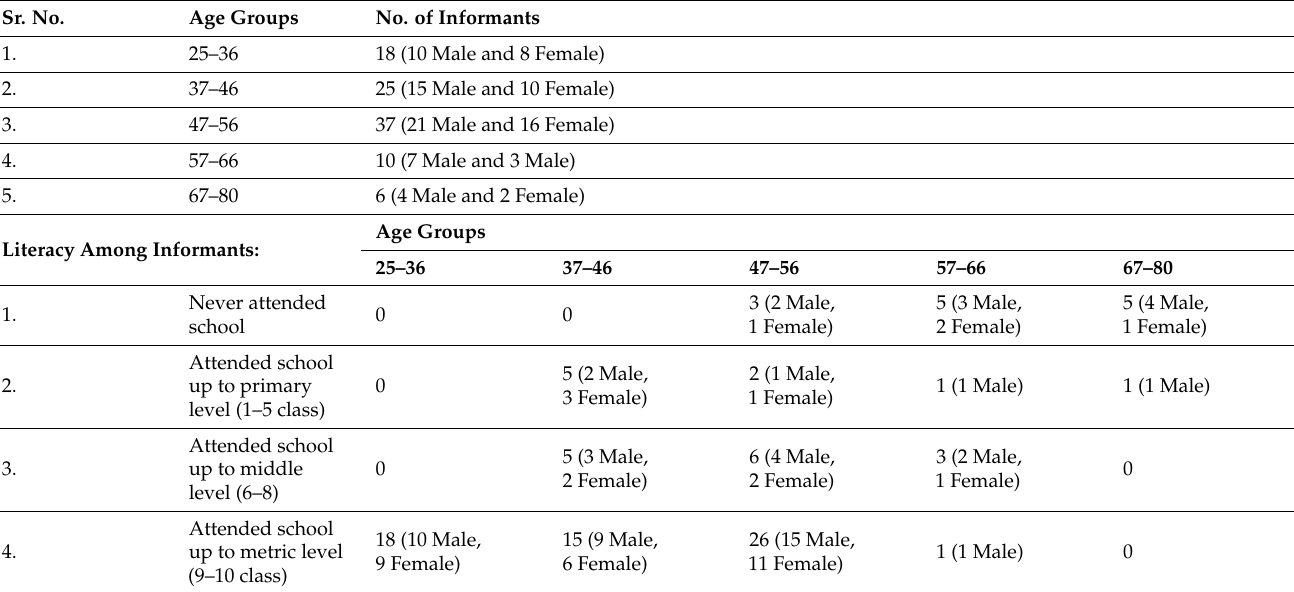
Table 1. Demography and literacy among